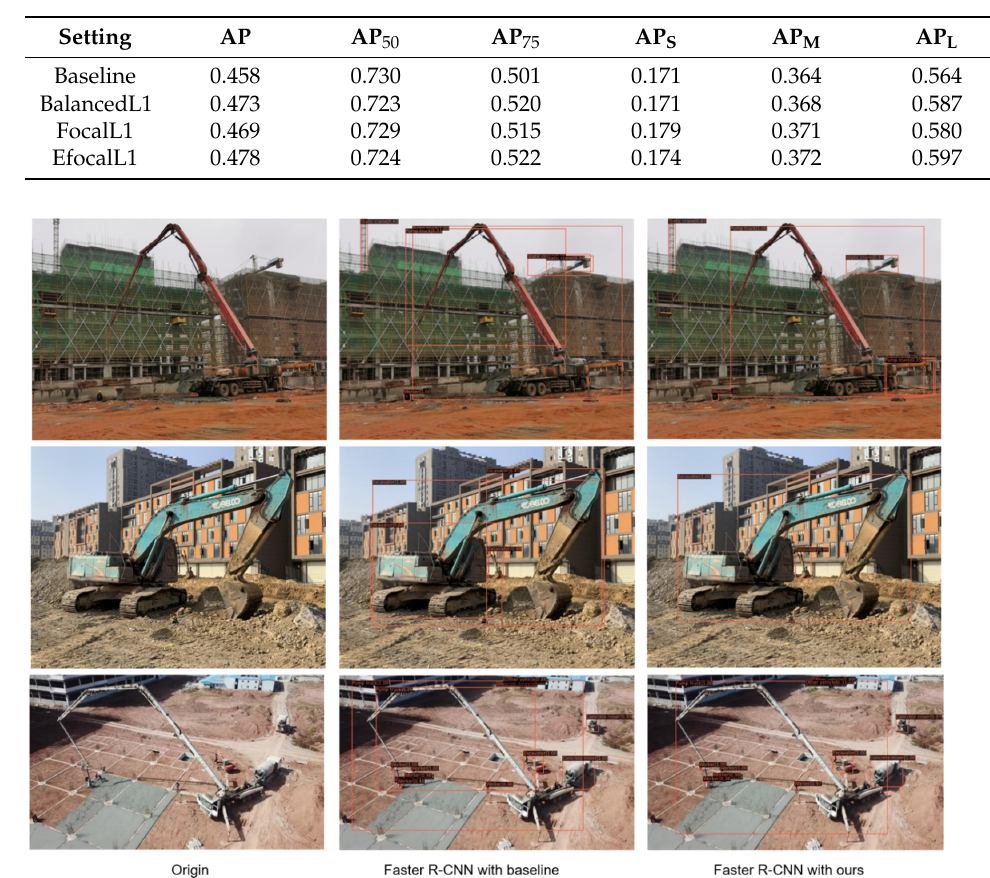
Figure 8. Comparison chart of object detection results.